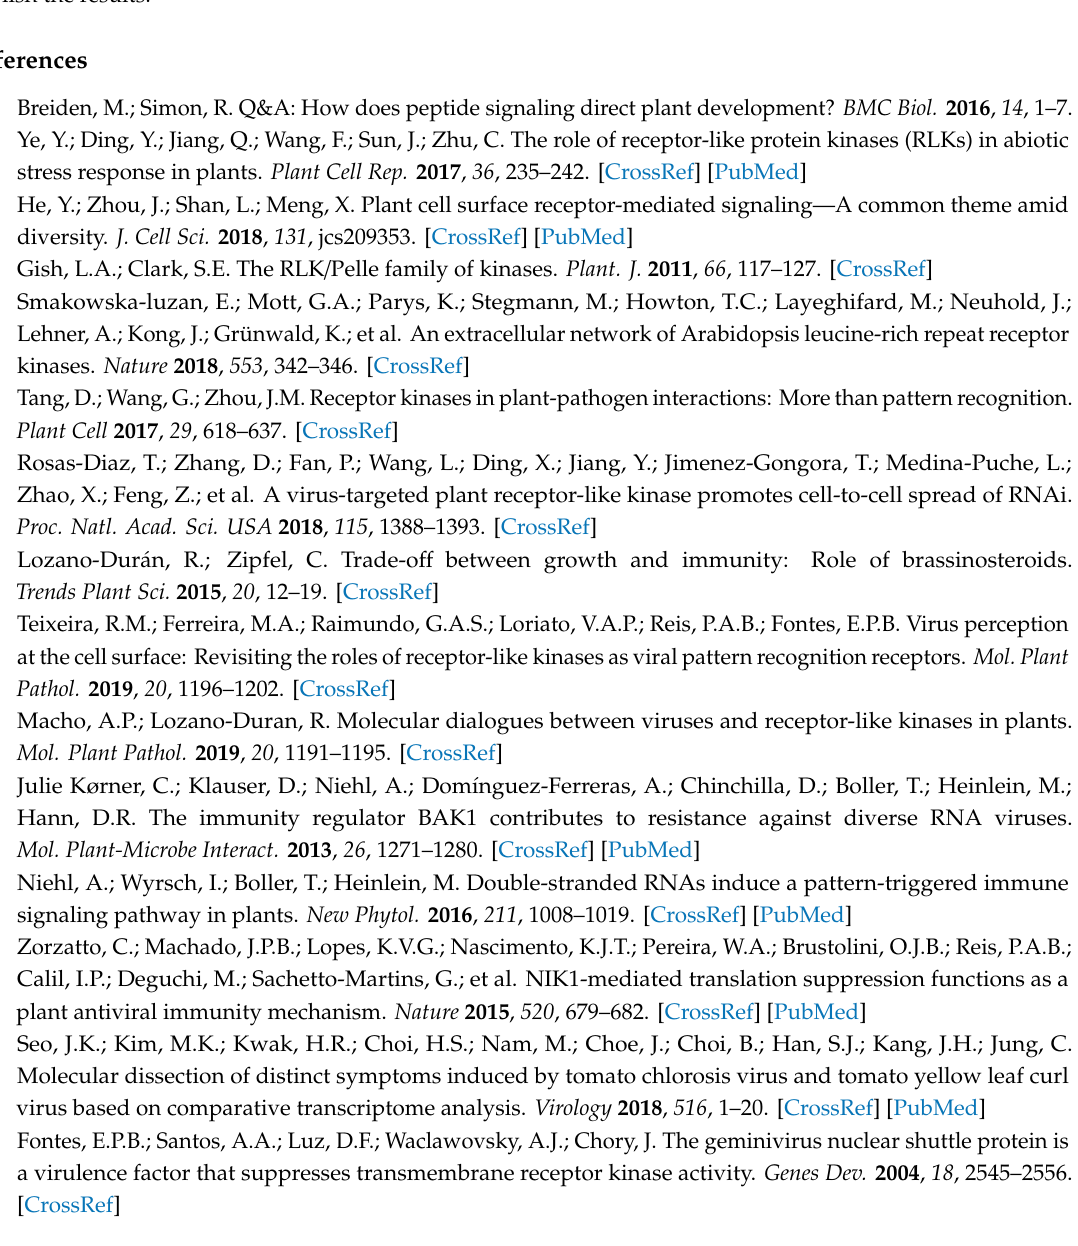
Figure S1: Alignment of the cytoplasmic domain of C4-interacting and non-interacting RLKs. Figure S2: Interaction landscape of C4 from TYLCV with selected members of the RLK family. Green lines indicate interactions detected; red lines indicate interactions not detected, Table S1: DNA oligonucleotides used in this